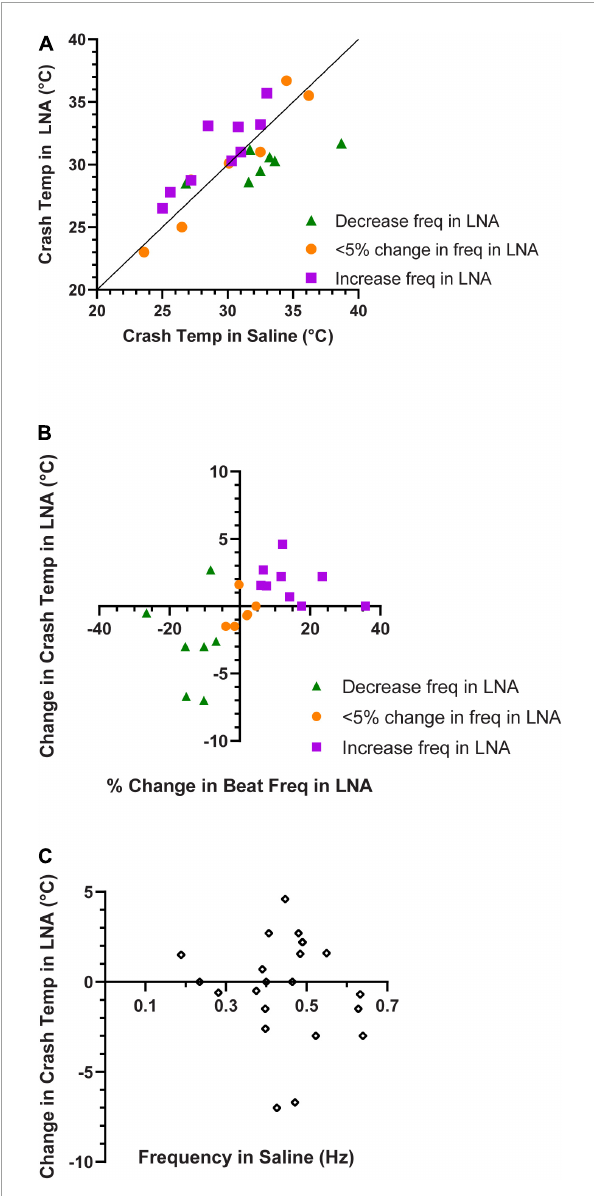
FIGURE10 Contraction frequency in LNA correlates with crash temperature. (A) Comparison of crash temperatures between whole heart preparations perfused with saline vs. L-nitroarginine (LNA) for the same preparations. The unity line indicates the value at which crash temperature is identical in saline and LNA. Preparations in which LNA led to an increase in contraction frequency are shown as green triangles (Wilcoxon Sign-Rank test; p = 0.047, N = 7); those in which LNA did not change the contraction frequency are depicted as orange circles (Wilcoxon Sign-Rank test; p = 0.56, N = 6), and those in which LNA led to and a decrease in contraction frequency are shown as purple squares (Wilcoxon Sign-Rank test; p = 0.016, N = 9). Note that most of the preparations in which frequency decreased in LNA are above the line (increased crash temperature in LNA), while most of those in which frequency increased in LNA are below the line (decreased crash temperature in LNA). (B) Plot of whole heart crash temperature in LNA as a function of their percent change in contraction frequency. Spearman’s Rank Correlation test: ρ = 0.64, d = 3.74, p = 0.0013, N = 22. (C) The change in crash temperature (LNA crash temperature–saline crash temperature) did not change as a function of the initial contraction frequency, Spearman’s Rank Correlation test: ρ = –0.25, d = –1.14, p = 0.26, N = 22.